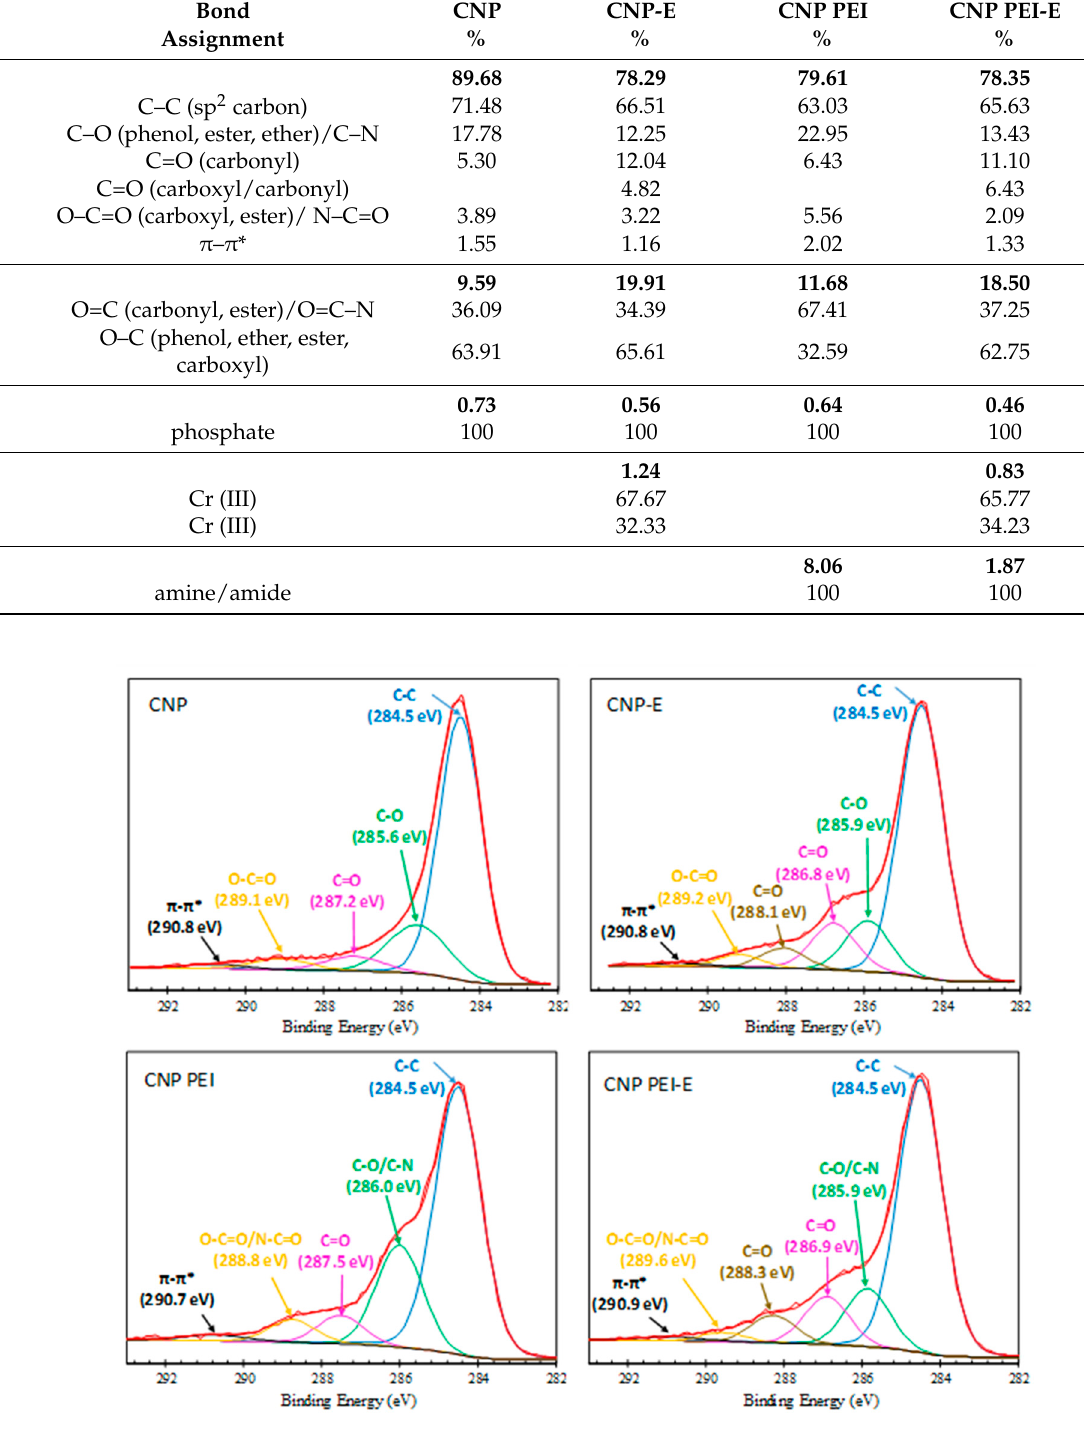
Figure 4. C 1s XPS spectra of CNP, CNP-E, CNP PEI, CNP PEI-E.